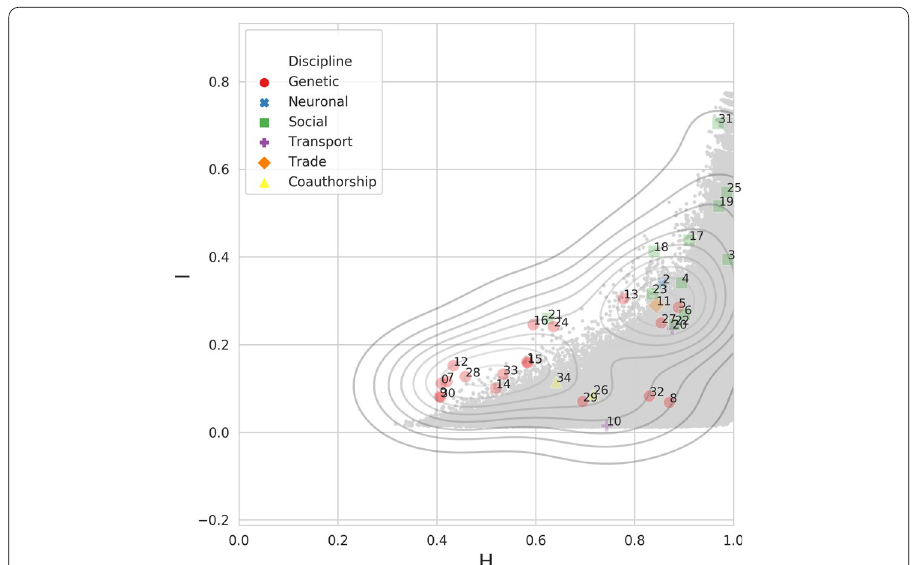
Fig. 14 Real networks: H × I . Labels of networks map to Table 1 (ID). Grey dots represent synthetic samples of Fig. 7, with Gaussian kernel density estimation over lines over the real world samples. Social networks shows a tendency to fall within the high homogeneity/intensity range, coinciding with the high inner-layer edge probability parameter p of synthetic